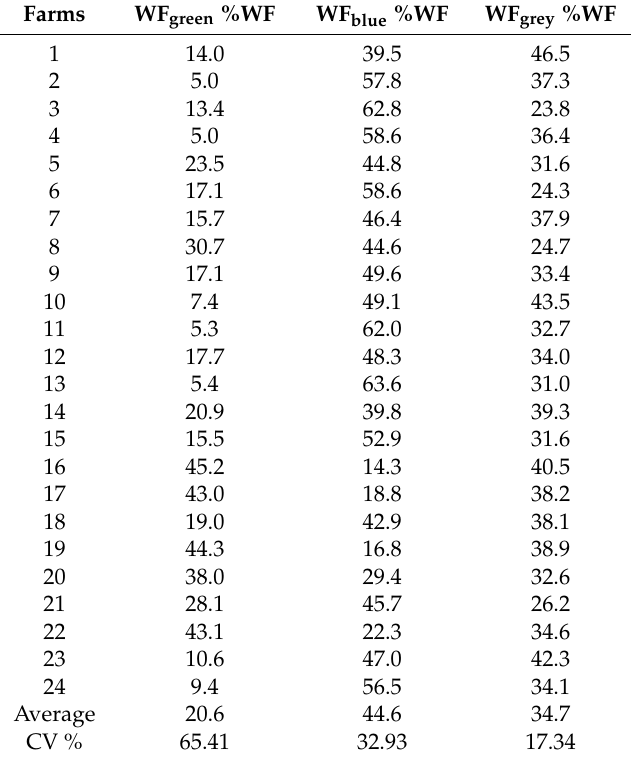
Table 3. Contribution of green, blue and grey footprints to total WF of industrial tomatoes, % to the total